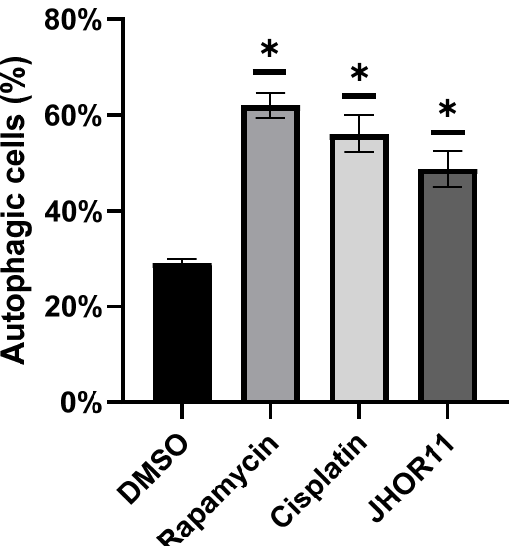
Figure 7. Percentage of autophagic cells after 48 h exposure of A2780 cells to IC 50 concentration of JHOR11, 0.1% ( v / v ) DMSO (vehicle control), 3.5 μ M cisplatin and 1.5 μ M rapamycin (positive con- trols). Bars represent the average ± SD of at least three independent experiments. * p value < 0.05 relative to vehicle control.